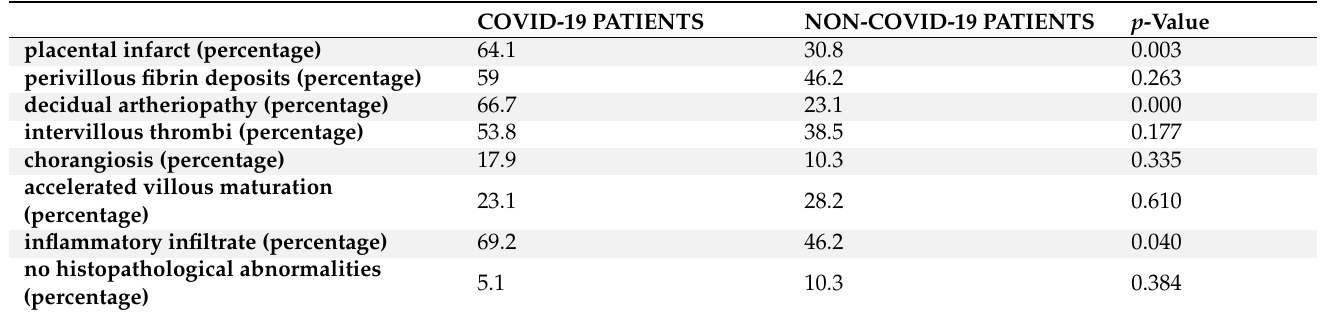
Table 3. Comparison of microscopic features of COVID-19 patients vs. controls.